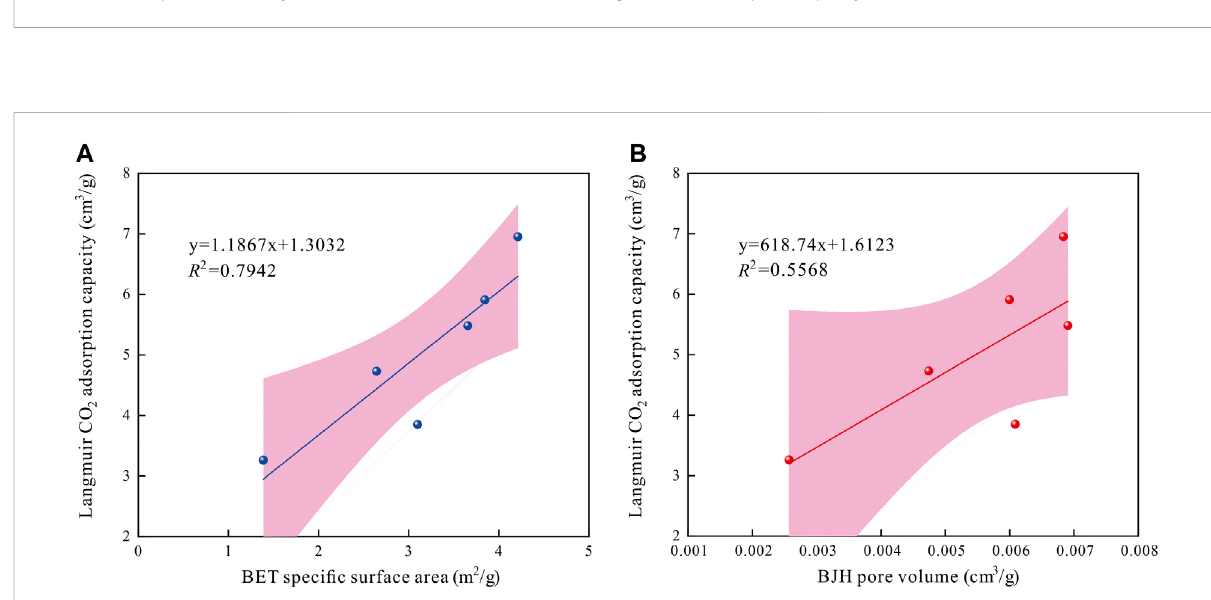
FIGURE 9 The relationships between clay content, brittle mineral content and Langmuir CO 2 adsorption capacity in shales.